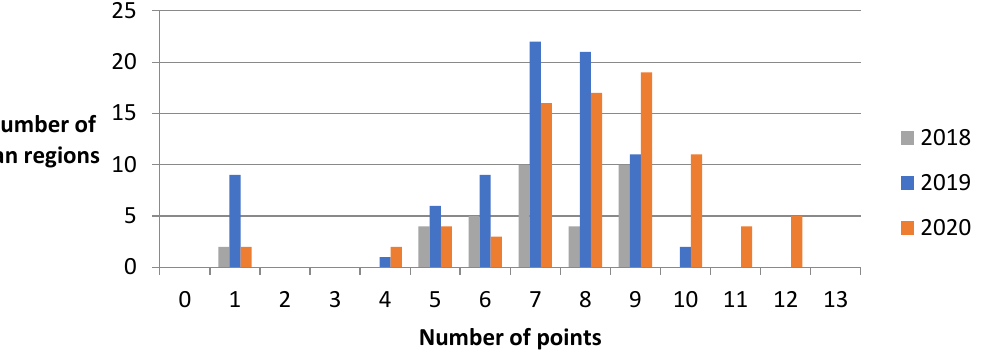
Figure 7. Distribution of the Russian regions based on the final point scores of the regional rehabilita- tion systems of comprehensive rehabilitation and habilitation.